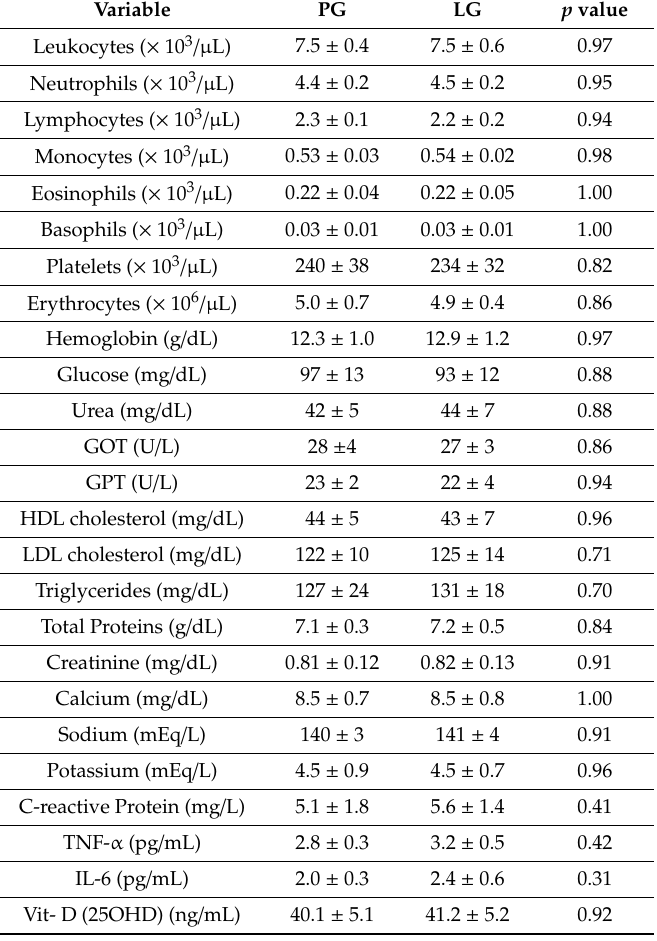
Table 2. Blood analysis and hemogram after treatment with placebo group (PG) or leucine group (LG).